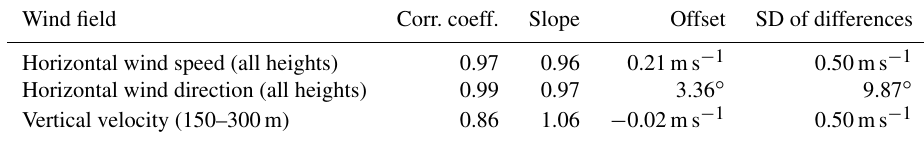
Figure 4. Scans performed by each of the scanning Doppler lidars to produce a 3-D volume of horizontal wind field. (a) Representation of the PPI sector scans performed by each lidar. (b) Grid points that have LOS velocities from at least two lidars and the colors indicate difference in azimuth between their respective look directions. Table 5. Statistics from comparison of wind-field measurements from the VTS to the sonic anemometer